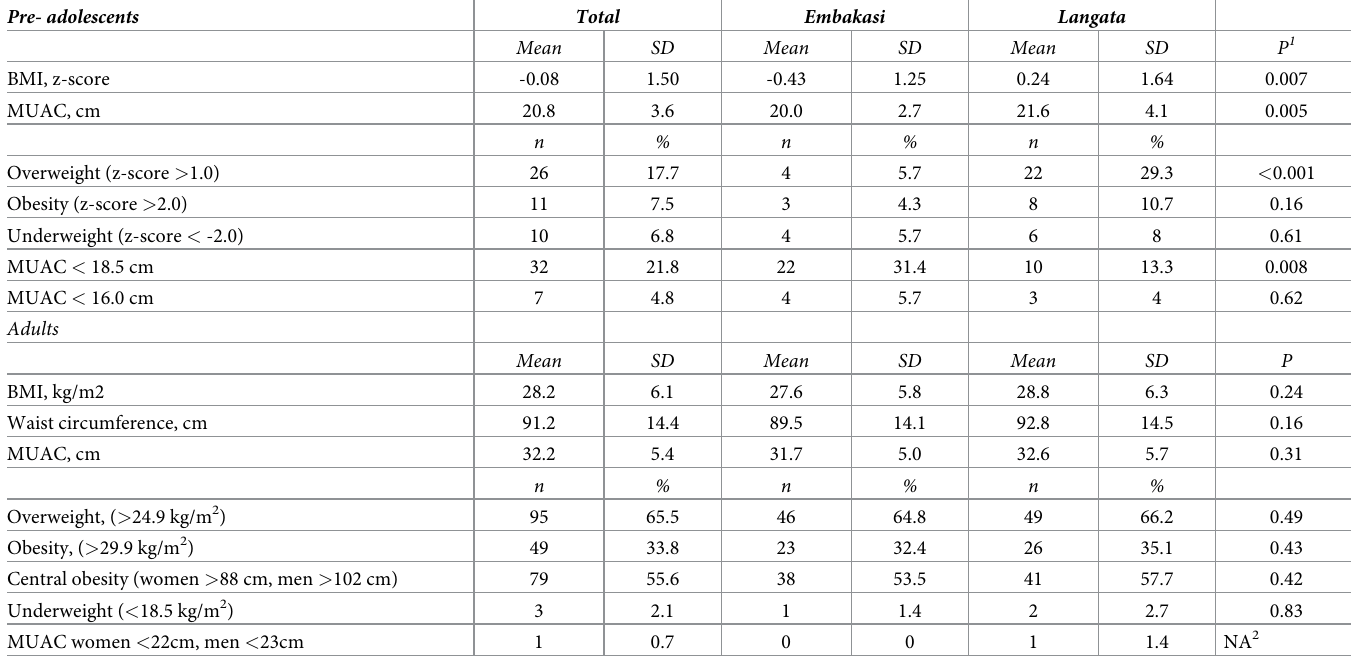
Table 2. Anthropometric measures and prevalence of underweight, overweight and obesity in pre-adolescents and adults (majority of the adults were women). Pre- adolescents